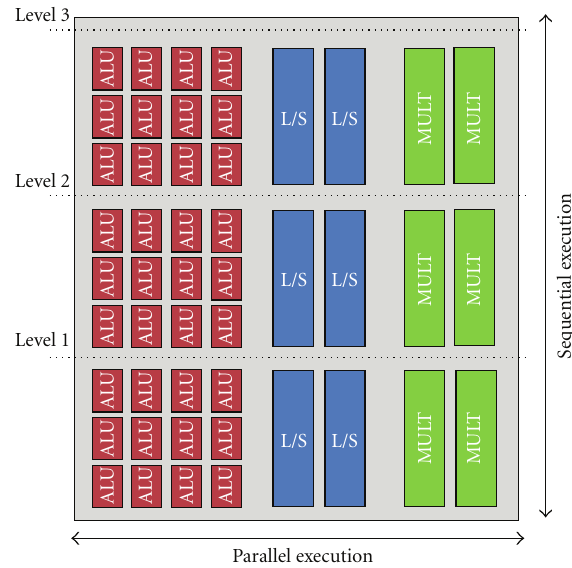
Figure 2: FAT-array block